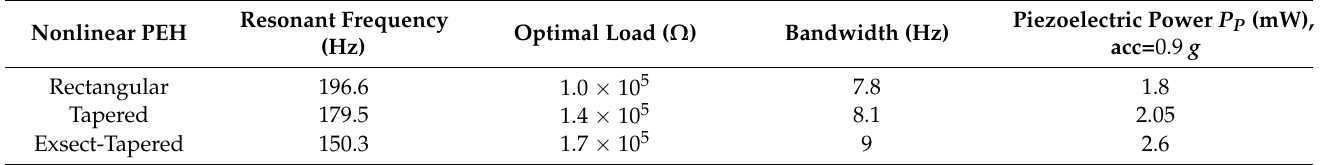
Figure 11. Analytical simulated output power for a varying frequency with load resistance R = 0.27 M Ω and different input excitations (acc) for forward (solid line) and backward (dash line) frequency sweeps in an exsect-tapered nonlinear PEH. Table 3. Comparison of output results for an input base excitation of 0.9 g.